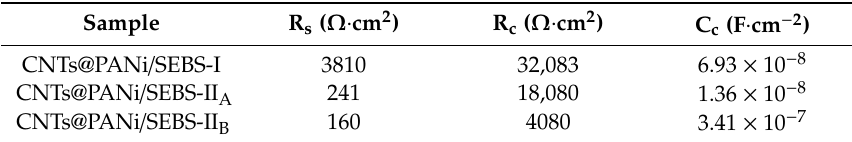
Table 1. Impedance parameters of CNTs@PANi / SEBS composite